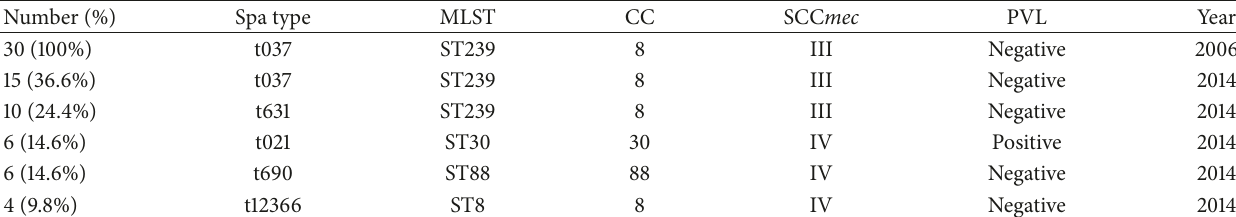
Table 1: Molecular characterization of MRSA strains isolated in the years 2006 and